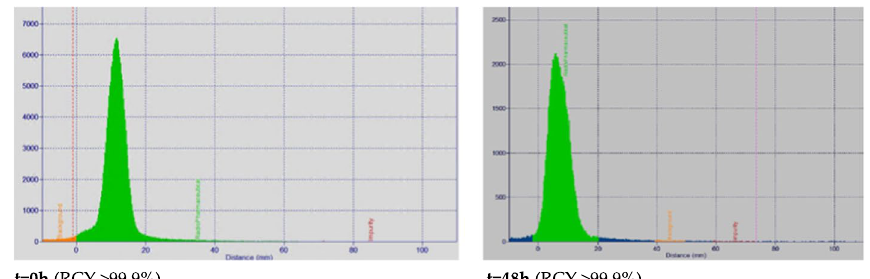
Fig. 1 Radio-TLC at time point 0 and 48 h, for radiolysis evaluation